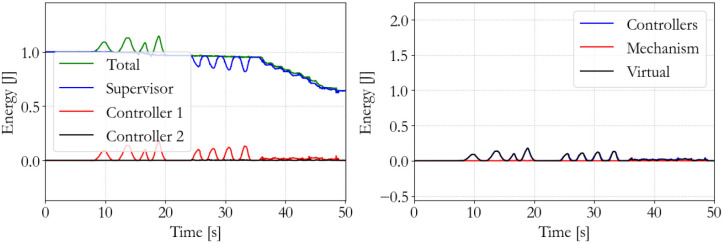
Slave energy levels.